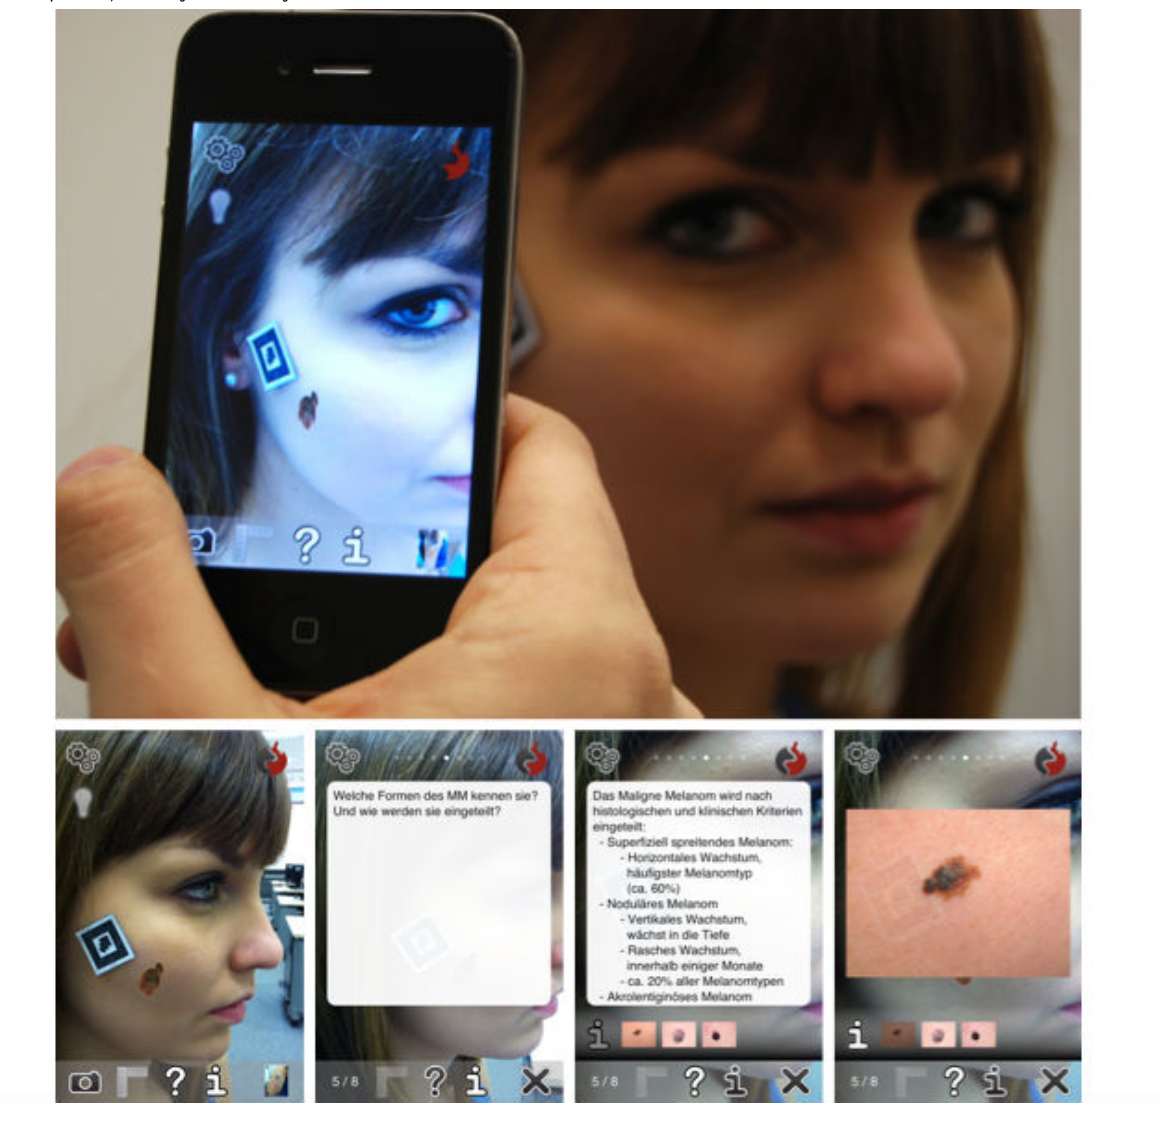
Figure 2. Upper row: Using mobile Augmented Reality (mAR), a malignant melanoma is simulated on the cheek of a student. Lower row: Screenshots taken within the mobile Augmented Reality blended learning environment (mARble) app. Left to right: Overlaid image, question side of a flashcard, answer side with links to additional image material, and a presentation of said image material. For the control group B, the app was provided without the mAR component, and they were solely able to access the flashcard-based